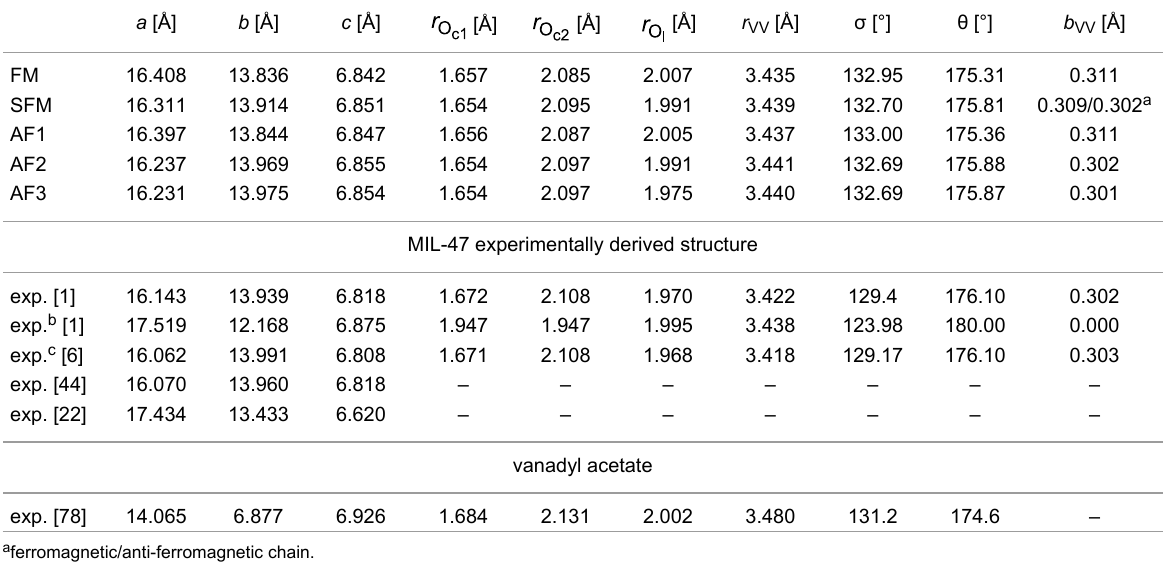
Although the separation in the b -direction ( b VV ) is rather